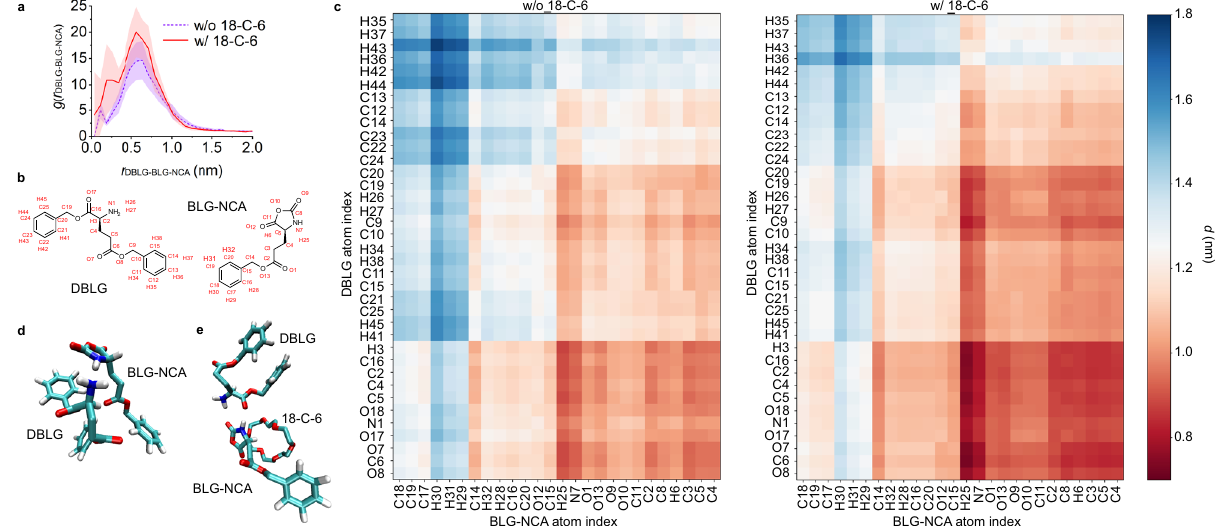
Fig. 6 Structural characterization of BLG-NCA (3 mM) and DBLG (30 mM) approach in the presence and absence of 18-C-6 (3 mM). a Radial distribution functions g( r DBLG - BLG-NCA ) in the center-of-geometry distance between BLG-NCA and DBLG molecules in the presence (red curve) and absence (blue curve) of 18-C-6. The shaded areas correspond to the estimated uncertainties in the curves computed by partitioning the production run into fi ve equal sized blocks and computing standard deviations over the blocks. The presence of CE increases the number of closely associated DBLG-NCA pairs, producing a 27% enhancement in number density of BLG-NCA/DBLG pairs within a spherical volume of radius r = 1 nm. b Scheme labeling the atom indices used for the contact matrices. c Contact matrices for the interatomic distances between the atoms comprising BLG-NCA and DBLG in the absence and presence of 18-C-6. Interatomic pairwise distances are averaged over all BLG-NCA/DBLG contact pairs with a center-of-geometry distance r fi gurations observed in the absence of 18-C-6 and 7129 con fi gurations in its presence. Standard errors in the DBLG-BLG-NCA < 1 nm, with 5774 such con computed distances are estimated by block averaging of the trajectory into fi ve equally sized contiguous blocks and in all cases are smaller than ±0.15 nm. The presence of CE changes the geometry of approach within the BLG-NCA/DBLG contact pairs. The most prominent effect is to induce the red sector in the bottom right of the contact matrix to become redder, indicating that the atoms participating in these contacts get closer. d , e Snapshots of a BLG-NCA and DBLG contact pair in a bimolecular complex and a termolecular complex comprising a mediating 18-C-6 molecule, BLG-NCA and DBLG. C = teal, H = white, O = red, N =